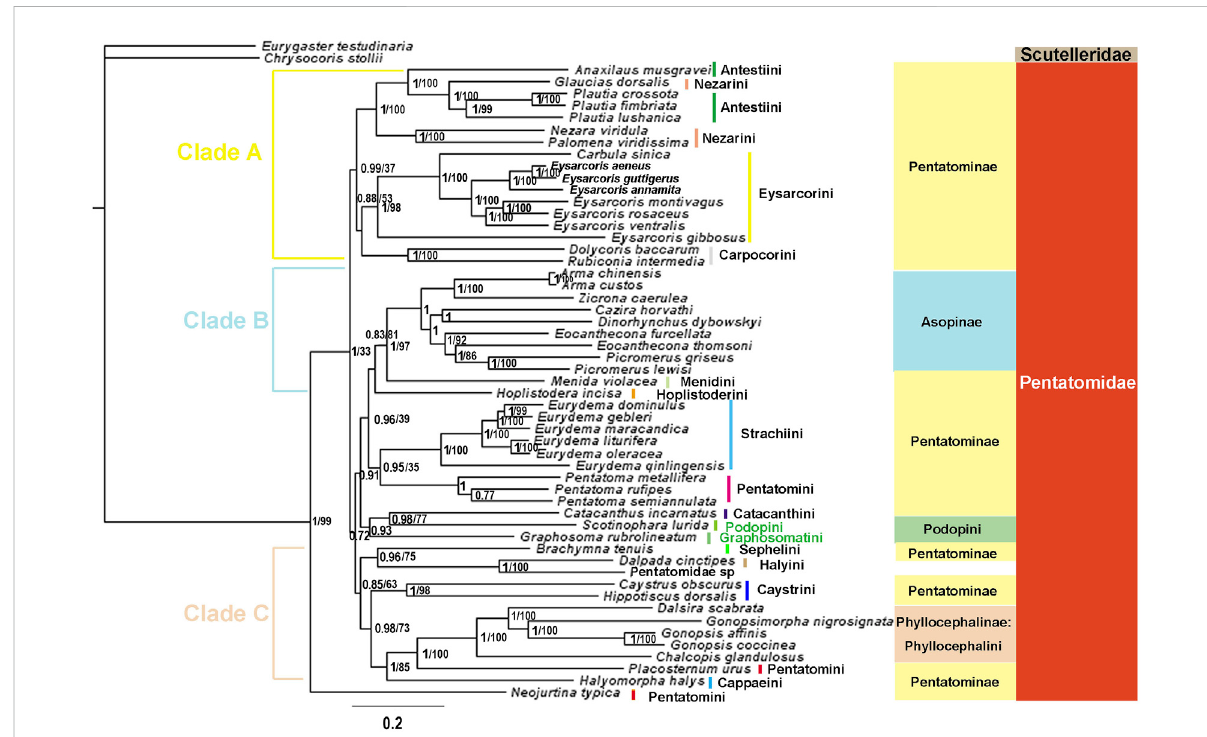
FIGURE 10 The phylogenetic trees of tribes within Pentatomidae were constructed from DNA sequences of 13 PCGs using BI and ML methods. Numbers on branches are posterior probabilities (PP, left) and bootstrap (BS, right). Note: Branches without BS values indicate that the topology is only supported by